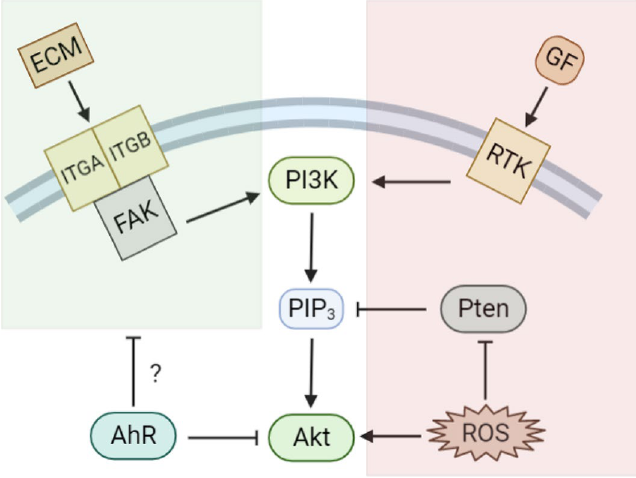
Figure 10. Depiction of potential AhR-dependent Akt activating pathways. In this study, we show that the presence of AhR reduced basal Akt phosphorylation. PI3K/Akt signaling pathway is activated by many types of cellular stimuli. Besides the canonical growth factor-mediated RTK/PI3K/Akt pathway, interactions between integrin and ECM can also transduce signals into the cell by activating the FAK/PI3K/Akt pathway; AhR may affect Akt phosphorylation through the regulation of these pathways. The red shaded area corresponds to the pathways not likely to be involved in AhR-dependent downregulation of Akt phosphorylation. The green shaded area represents the potential pathway by which AhR could modulate Akt phosphorylation. ECM extracellular matrix, GF growth factors, ITGA integrin subunit alpha, ITGB integrin subunit beta, FAK